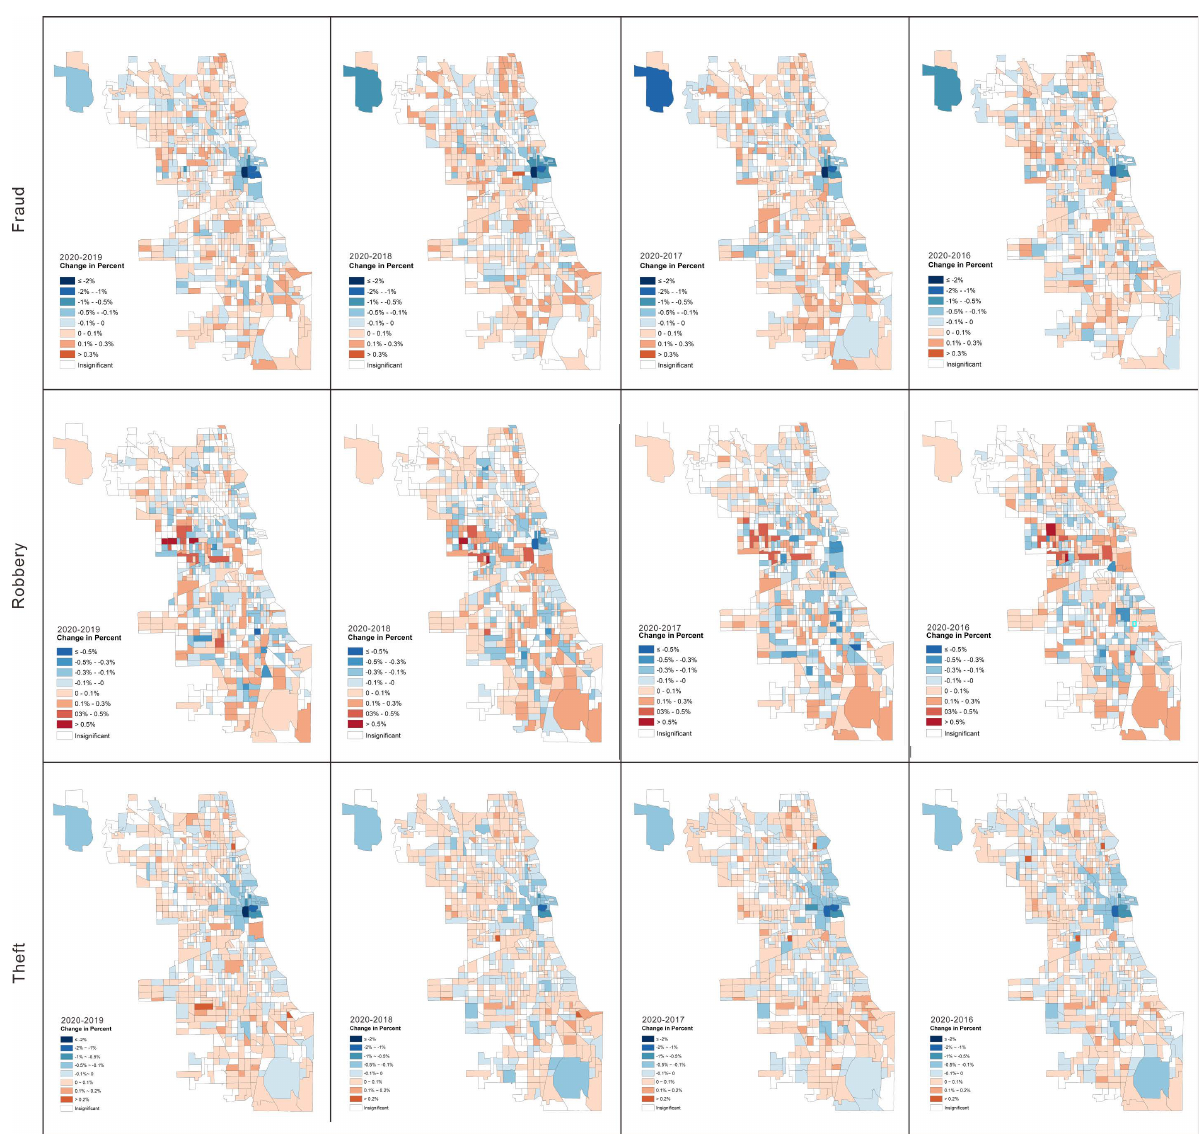
Figure A1. Results of local changes in 2020 compared with 2019, 2018, 2017, and 2016. “2020-2019” in the figures means that the crime data of 2020 are the base dataset, and the crime data of 2019 are the test